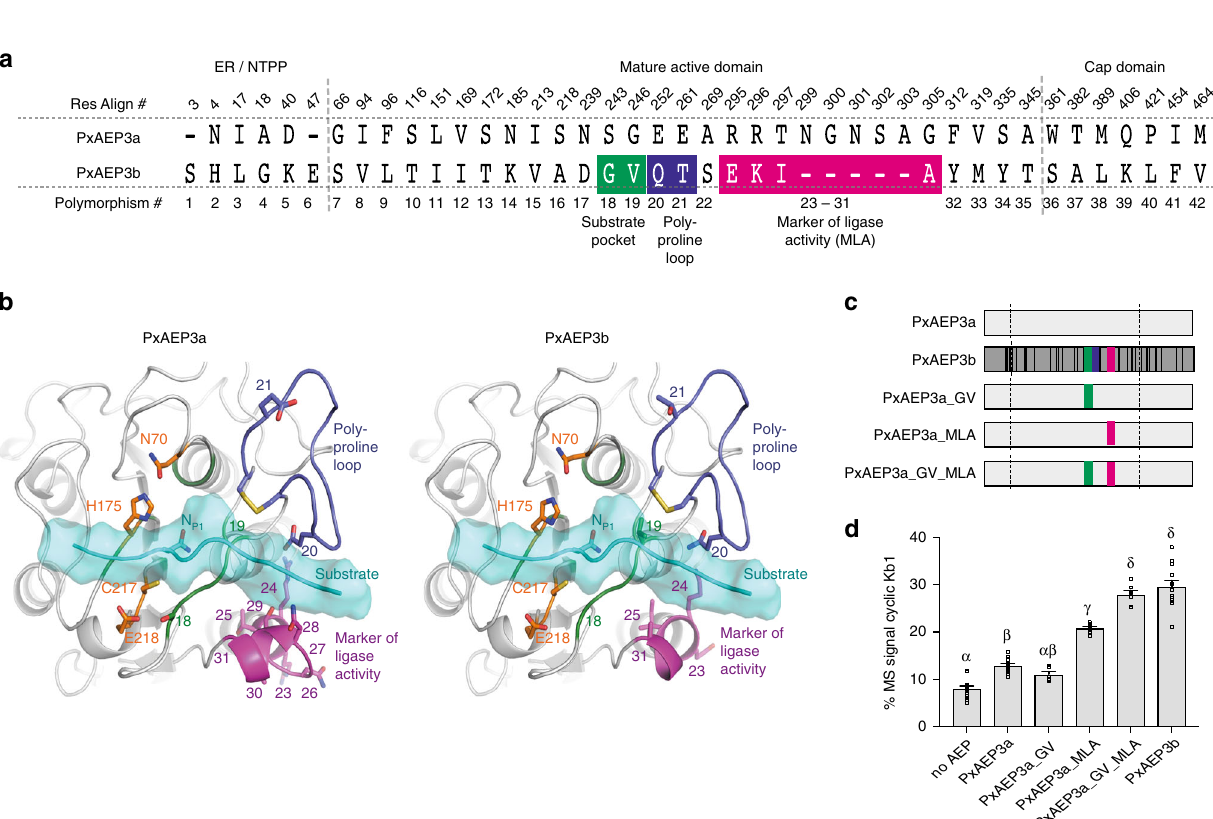
Fig. 2 Identi fi cation and functional testing of the key structural features unique to the petunia ligase PxAEP3b. a Polymorphic residues between petunia isoforms PxAEP3a and PxAEP3b (see also Supplementary Fig. 3 for residue alignment). Those closest to the substrate pocket include polymorphisms 18 and 19 (green), polymorphisms 20 and 21 (blue) within the poly-proline loop and polymorphisms 23 – 31 (magenta) here named the marker of ligase activity (MLA). b Homology model of the substrate-binding site of the catalytic domain of PxAEP3a (left) and PxAEP3b (right). A substrate peptide bound in the binding site (cyan) was modeled by homology using the structure of human AEP (PDB ID: 4awa; www.rcsb.org) bound to a suicide substrate and extended at the C-terminus by a polyalanine peptide. The asparagine residue in the P1 pocket is noted N P1 . Polymorphic positions in and around the substrate pocket are shown as sticks, numbered and colored according to panel a . The catalytic residues are represented in orange sticks and numbered according to homologous residues on OaAEP1 b . c Schematics of petunia AEP genes prepared to test the in fl uence of polymorphic residues on the in planta cyclization of the kB1 precursor. Colors used in the bars represent the same regions and colors in panel a . d MALDI- MS analysis of N. benthamiana -produced peptides upon co-expression of petunia AEP variants with Oak1 . For all treatments, means and s.e.m. are of the percentage MS signal obtained for cyclic kB1 over the total MS signal of all kB1-related peptides produced. Treatments carrying unique Greek lettering are signi fi cantly different ( P < 0.05) as determined by Tukey ’ s ANOVA. Replicates are as follows: n = 14 (No AEP), n = 16 (PxAEP3a), n = 6 (PxAEP3a_GV), n = 8 (PxAEP3a_MLA), n = 6 (PxAEP3a_GV-MLA), and n = 12 (PxAEP3b). Error bars are